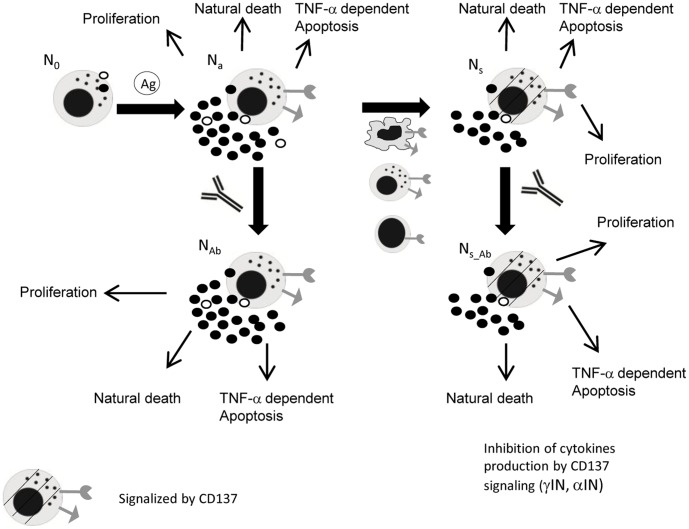
Diagram of CD56bright NK cell dynamics in the in vitro culture.Five different NK subpopulations are described: resting (N0), activated (Na), activated and signaling through CD137 (Ns), activated, signaling and blocked by anti-CD137 mAb (Ns_Ab) and activated and blocked (NAb). Rows indicate possible mechanisms for each subpopulation. The loss of N0 is modeled as NK activation (rate k(N0,Na)A) and death (µN0). N0 activation (Na) requires IL12 (indirectly modeled as activated APC), activated APC and M.tb. The model includes activation and signaling in two steps. Therefore, Na dynamics includes CD137 signaling by APC or NK cells, natural death, TNF-α induced-apoptosis and proliferation. Ns dynamics includes IFN-γ/TNFα induction by CD137 (IγN, IαN). NAb is defined by equations similar to Na, but with the receptor bound to anti-CD137 blocking mAb. Ns_Ab behaves as Ns, but the receptor is also blocked. We assume that all activated NK cells produce IFN-γ, but only a fraction produce TNF-α and expresse ligand/receptor pair.